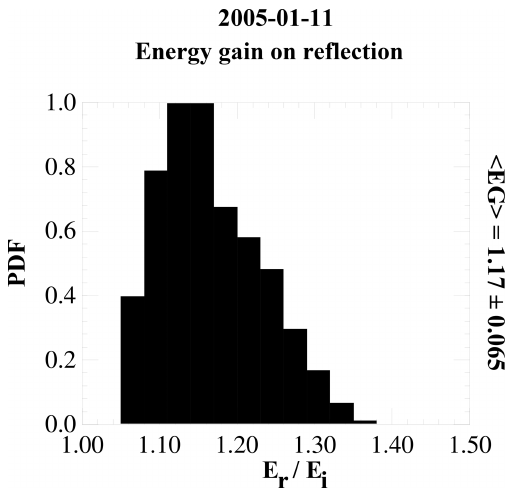
Figure 5. PDF plot of the energy gain on reflection from the bow shock. The PDF was formed from the results of the energization model by varying the shock normal and magnetic field components within a 1 σ band about their average values. The average energiza- tion and the 1 σ value are shown to the right of the plot.